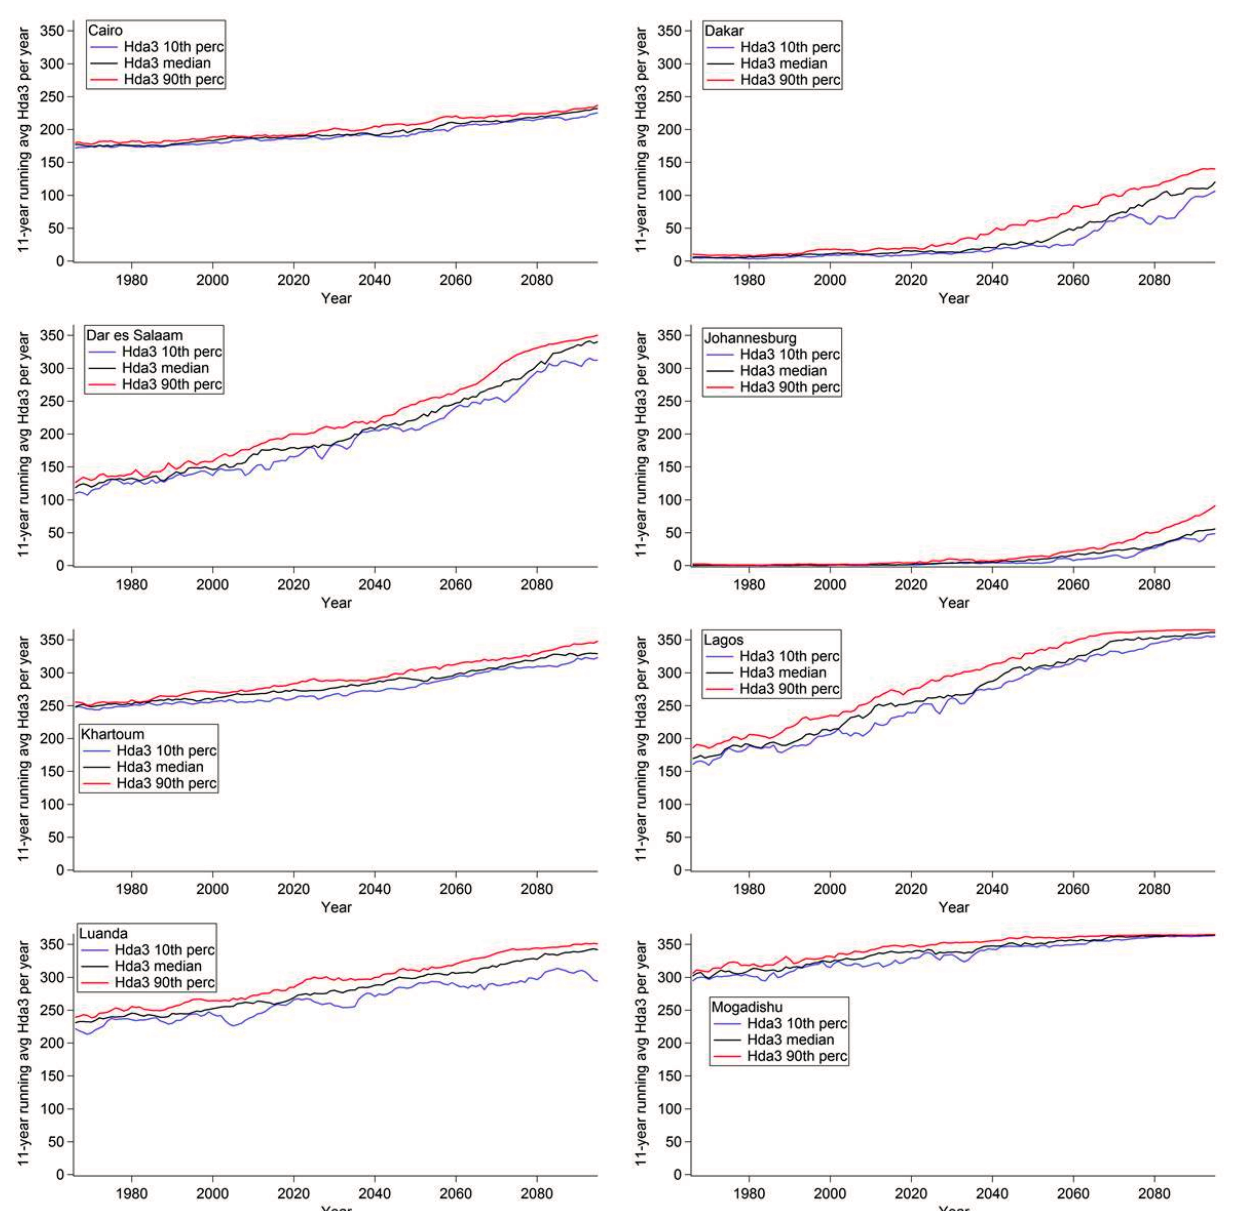
Figure 5. Eleven-year moving average of the number of Hda3 per year in selected cities in Africa. The ensemble 10th percentile (blue), the ensemble median (black) and the ensemble 90th percentile (red) of number of days per year are